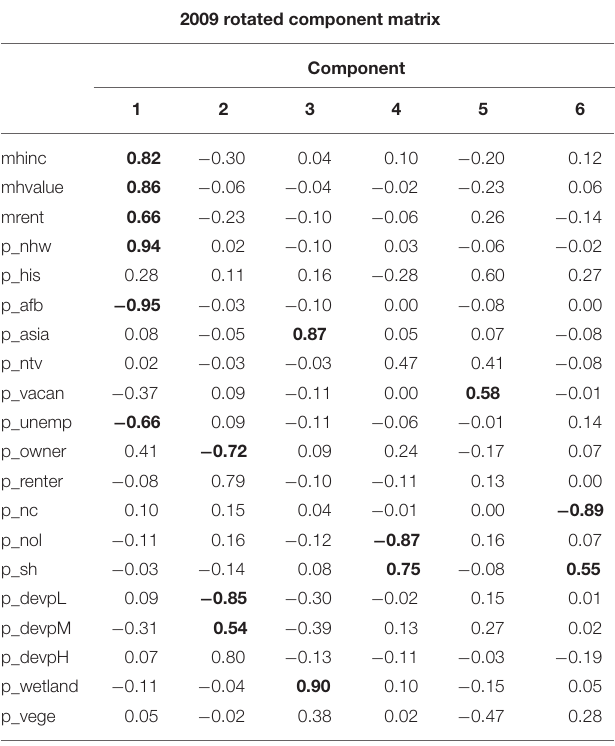
TABLE 7 | Results of principal component analysis using data from year 2009. 2009 rotated component